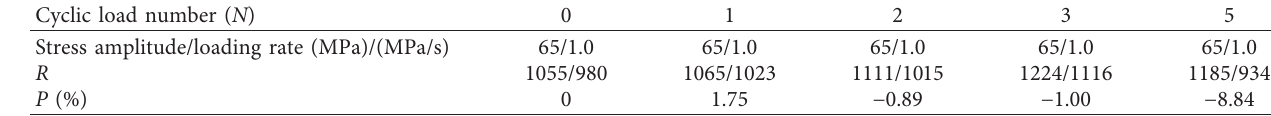
Table 2: The percentage of domain switching after cyclic loading.